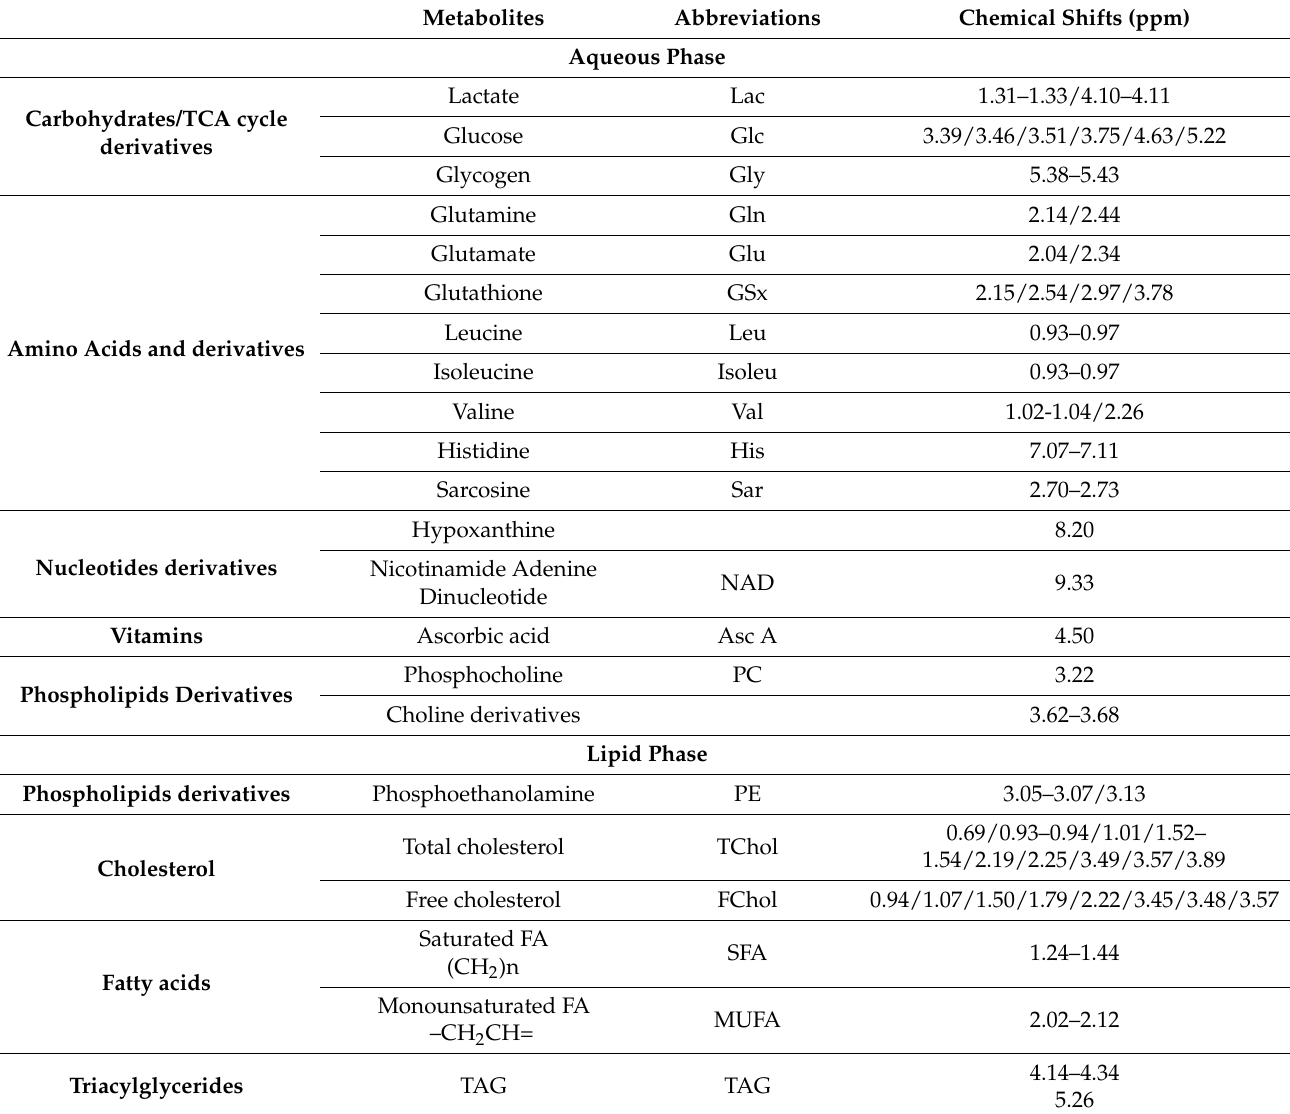
Table 2. List of discriminant metabolites identified with 1 H-NMR spectroscopy and corresponding